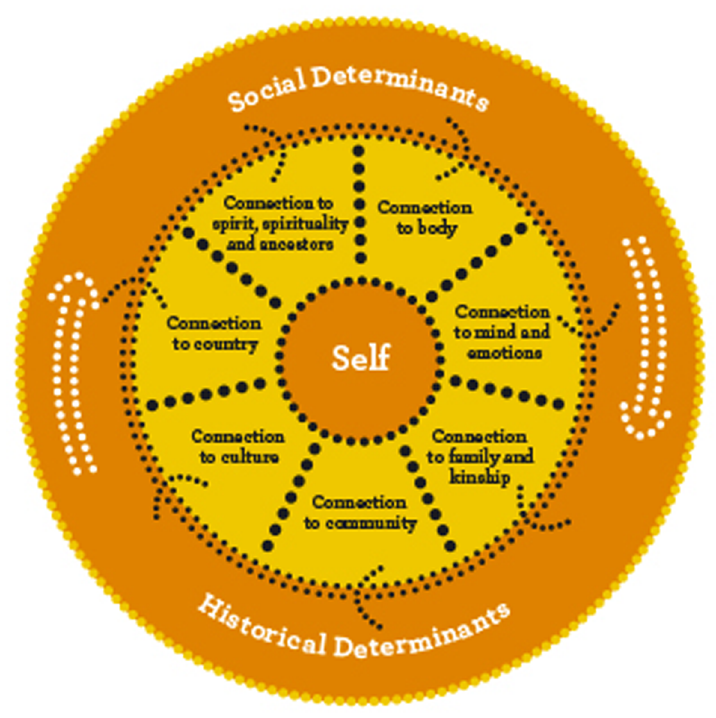
Figure 1. Determinants of social and emotional